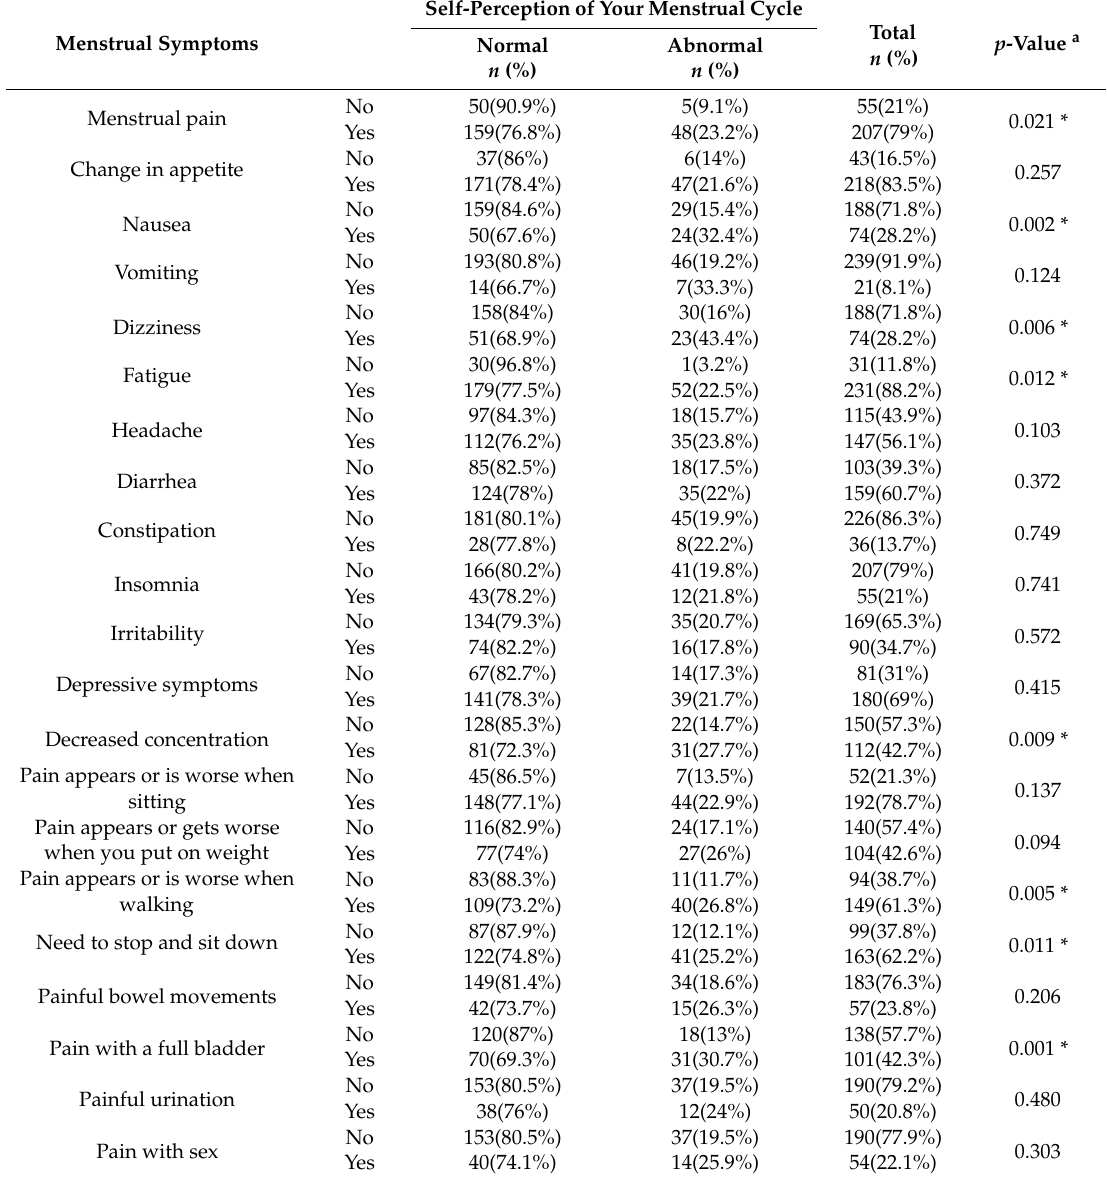
Table 2. Comparison of menstrual symptoms in women with normal and abnormal menstrual periods. Self-Perception of Your Menstrual Menstrual Symptoms